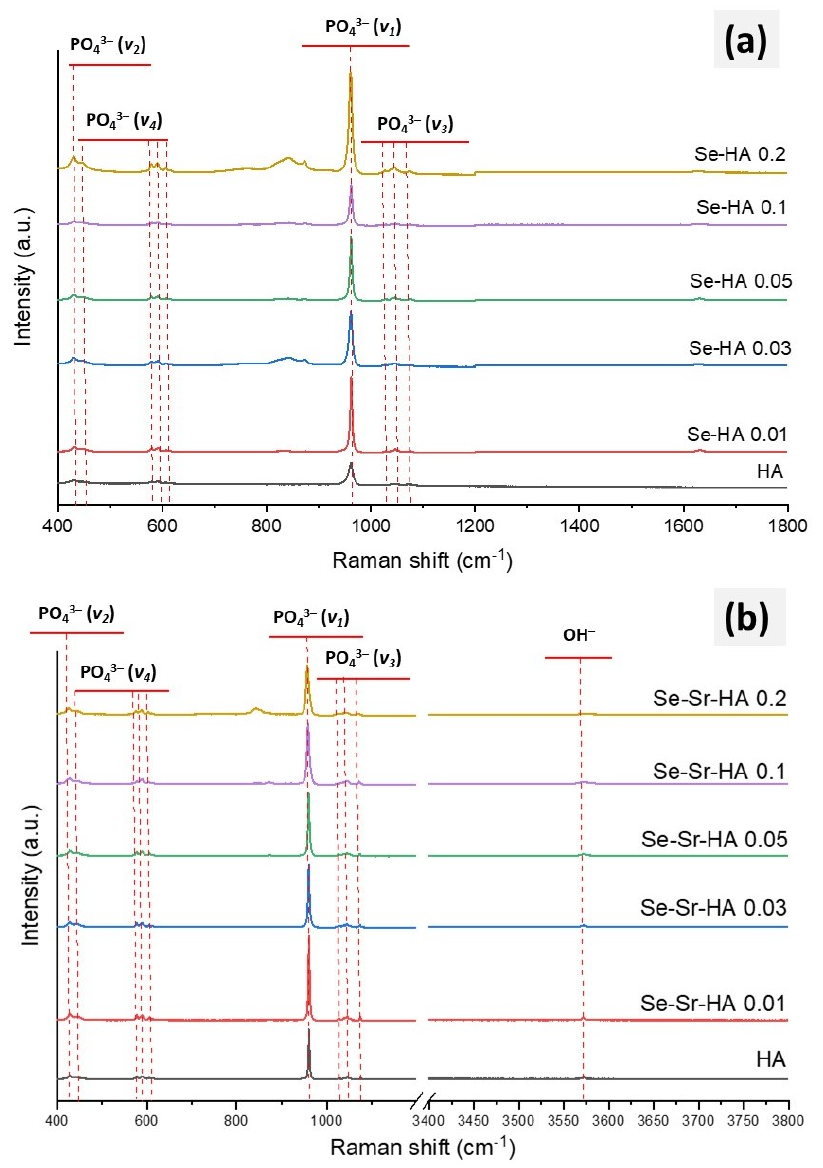
Figure 3. Raman spectra of sintered Se-HA ( a ) and Se-Sr-HA ( b ) at different molar ratios of Sr/(Sr + Ca) and Se/(Se + P).